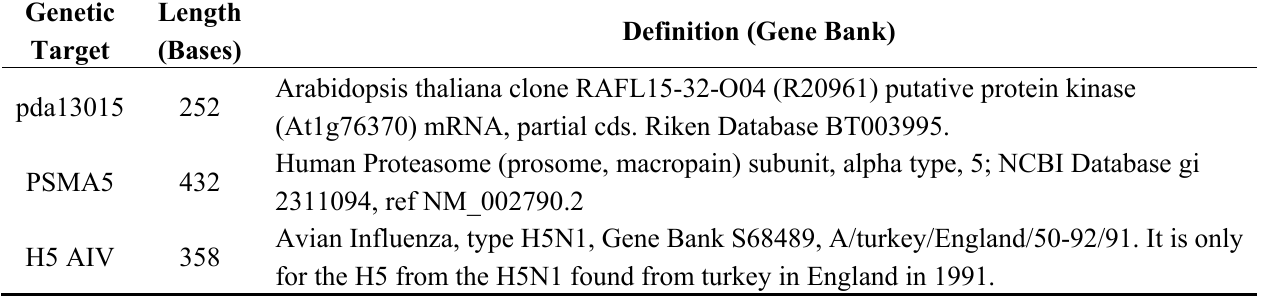
Table 1. The DNA analytes and their gene information.